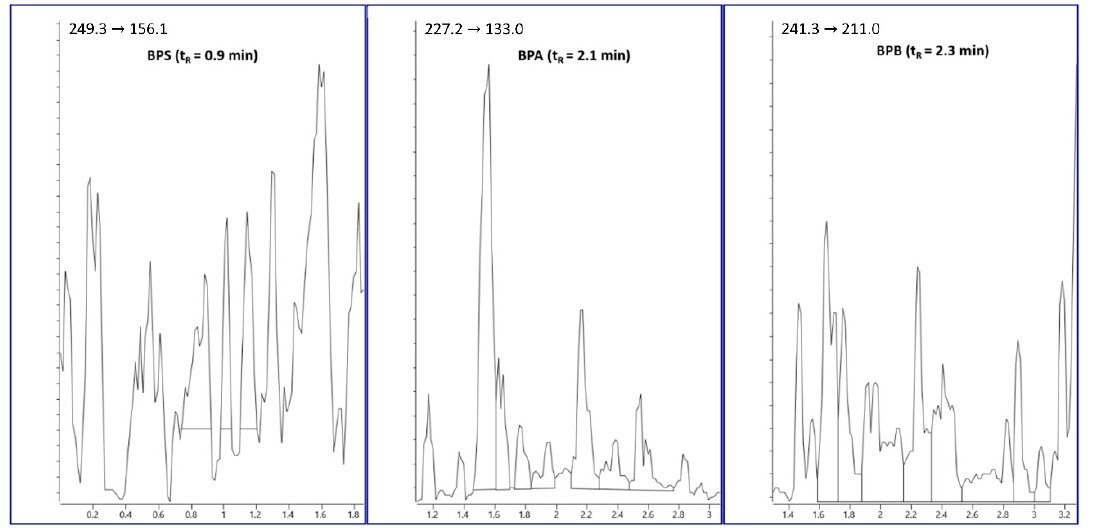
Figure 3. The -MRM ion chromatogram of the blank matrix.